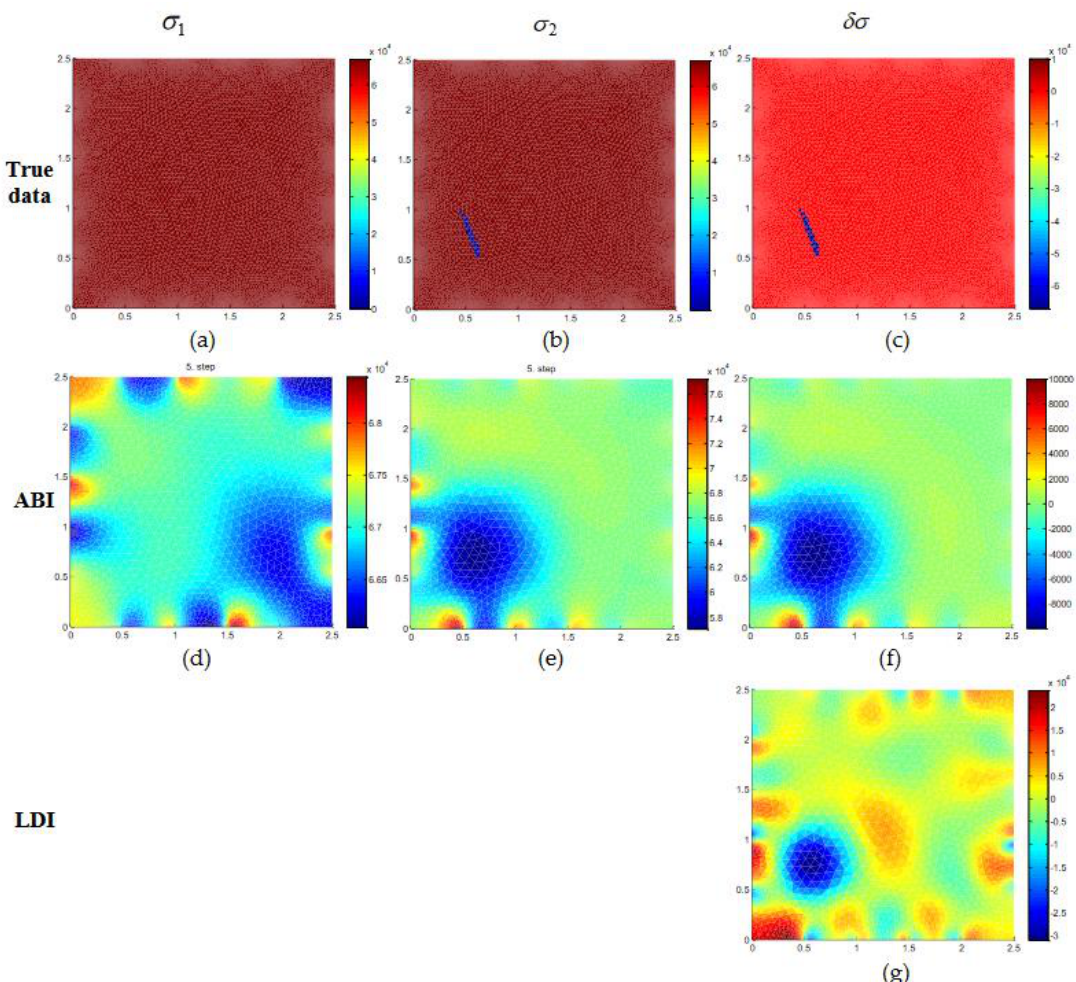
Figure 3. Numerical simulation of graphene conductivity estimation for test case 1 with 0.5% relative noise. ( a – c ) The top row is the true conductivity distribution while the second row ( d – f ), third row ( g ) are estimated conductivities of initial distribution ( σ 1 ) , final distribution ( σ 2 ) , and conductivity change ( δσ ) using absolute imaging (ABI) and linear difference imaging (LDI).